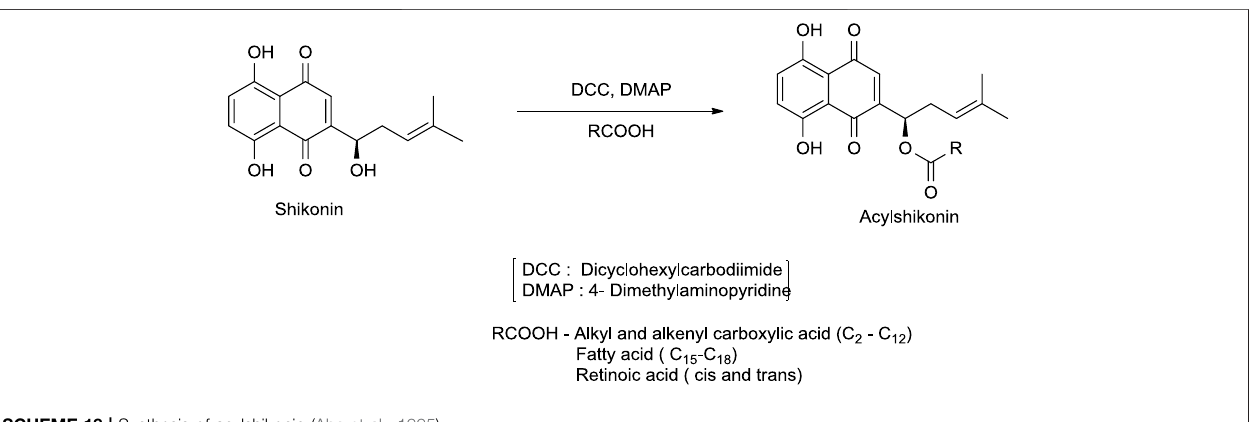
SCHEME 18 | Synthesis of acylshikonin (Ahn et al.,